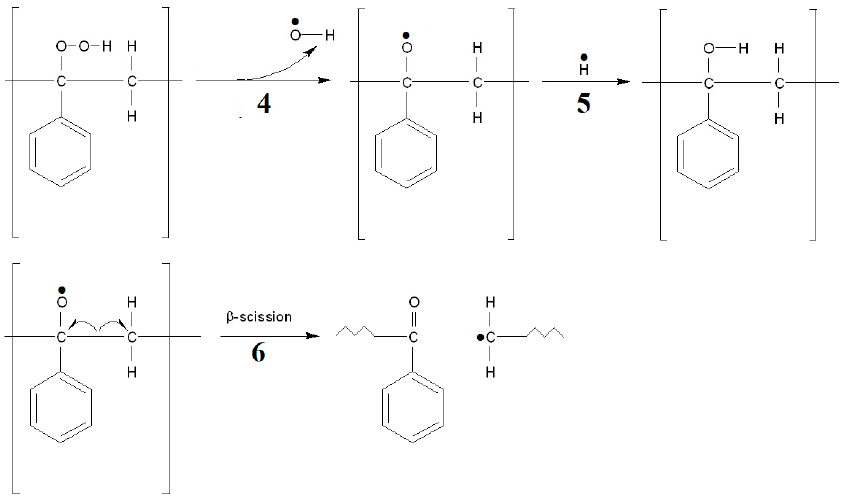
Figure 14. The proposed degradation pathways of tertiary hydroperoxide. The following symbols were applied: 4—decomposition of the hydroperoxide on the O-O bond with departure of the OH radical; 5—reaction of the resulting tertiary oxide radical with formation of alcohol; 6—decomposition at the position of the tertiary oxide radical.